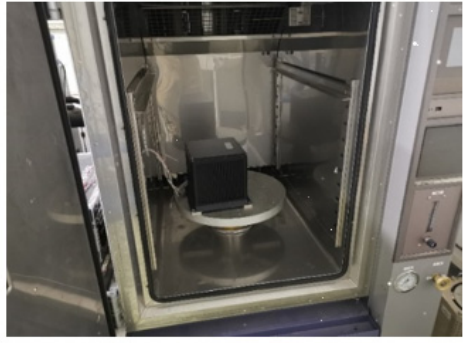
Figure 8. INS in temperature-controlled oven.